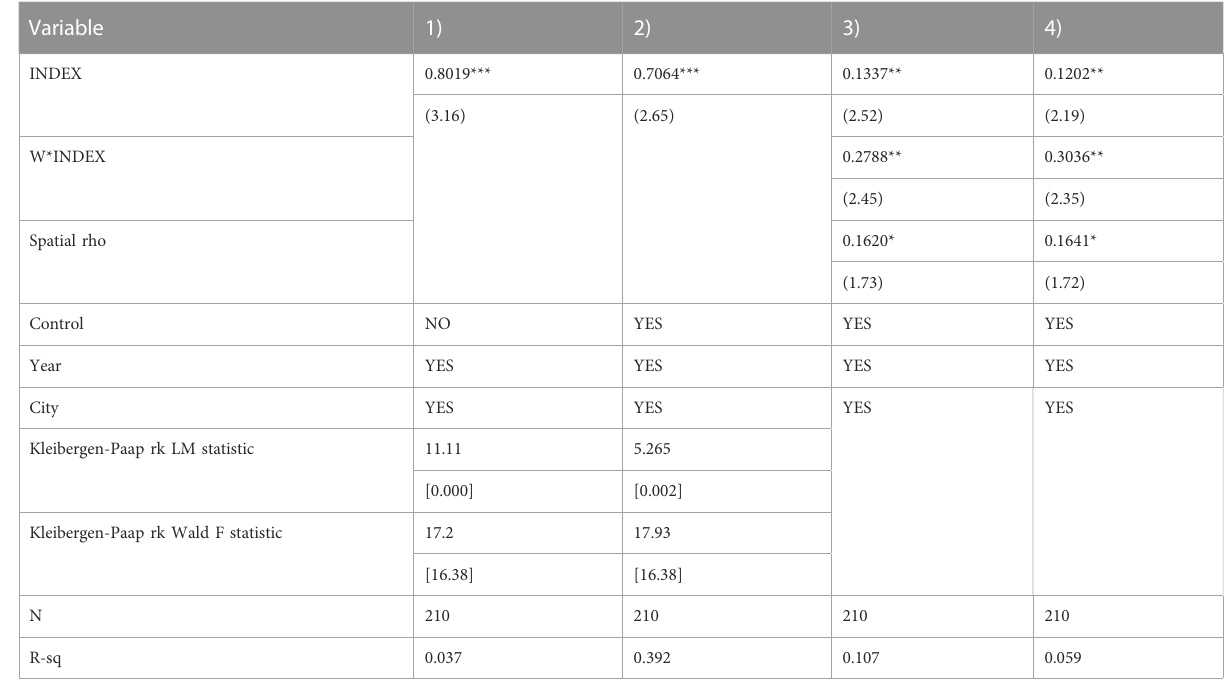
TABLE 6 Robustness test